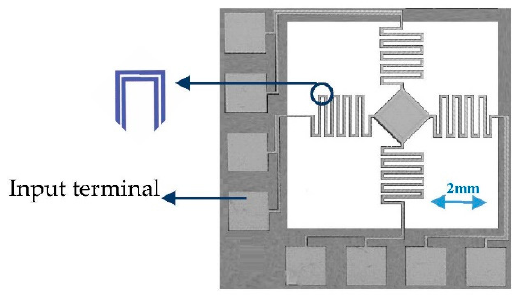
Figure 3. A fabricated mirror. Expanded view ( left ) shows the two conductor wires on the spring.